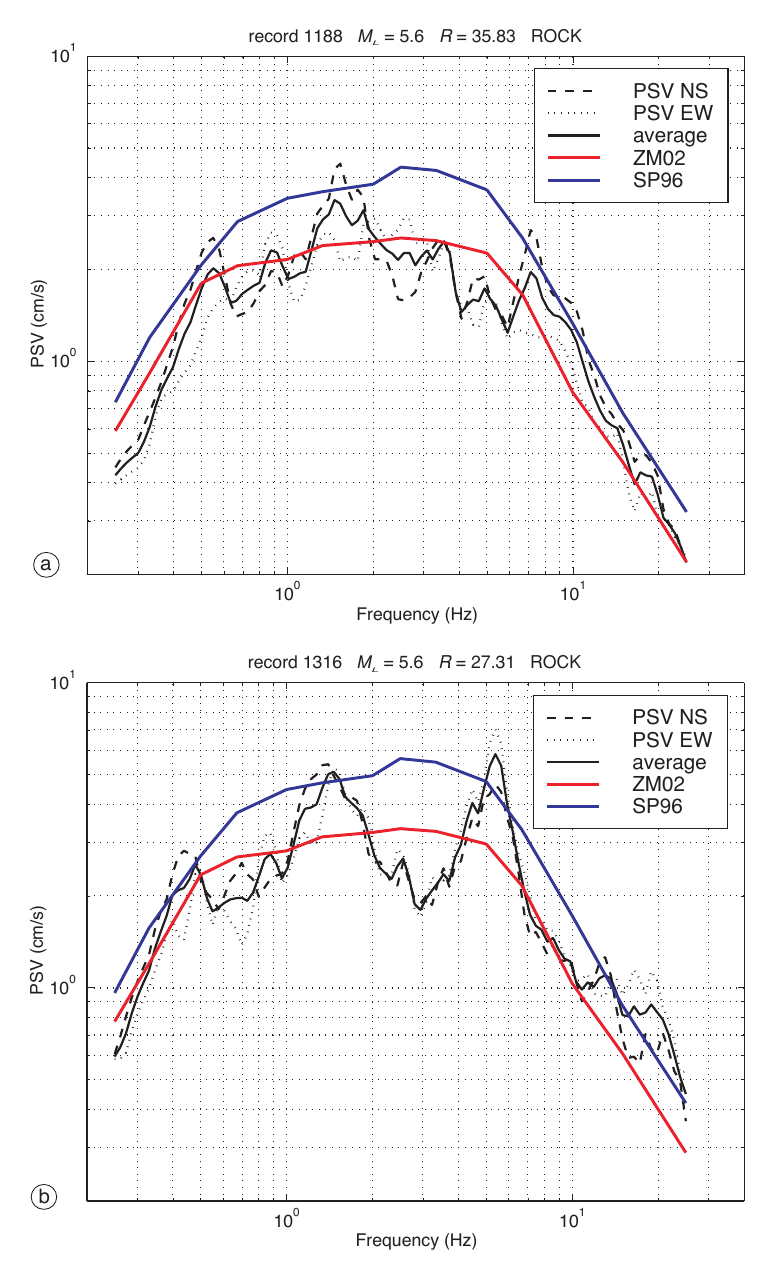
Fig. 4a,b. Comparison between PSV derived from processed records (black curves) and PSV calculated using ZM02 (red curve) and SP96 (blue curve). Figure 4a shows the case of RA01188 recorded at the site of Cascia during 26th September 1997, M = 5.6 earthquake; in fig. 4b the case of RA01316, recorded of Spoleto Monteluco L during 14th October 1997, M = 5.6 L